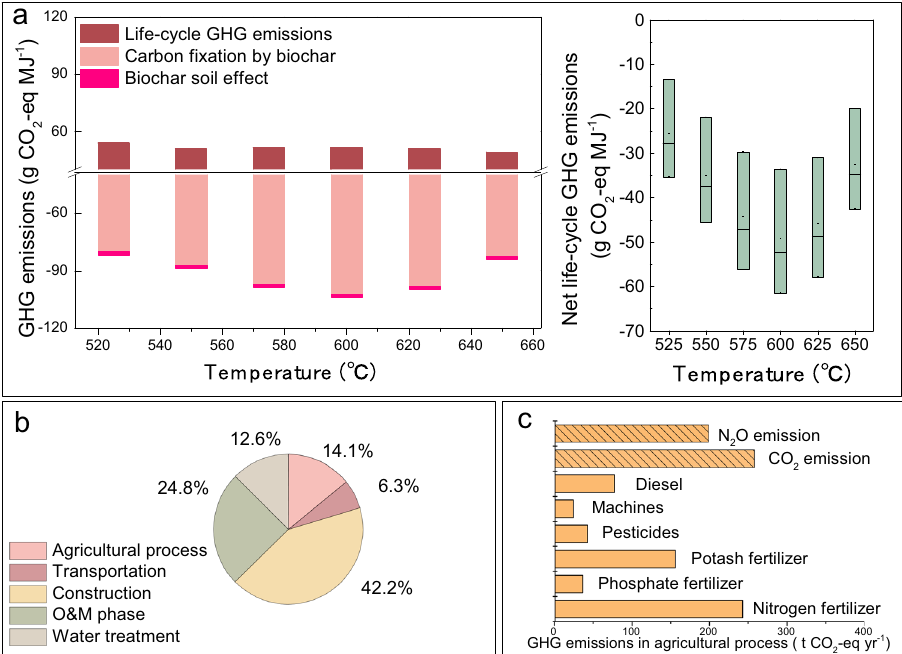
Fig. 3 The GHG emissions for a demonstration BIPP system with biochar sequestration (excluding fossil fuel offset). a Left fi gure presents life-cycle GHG emissions, carbon fi xation by sequestering biochar into soil (in fl uenced by the stability of biochar), and reduced emissions by biochar soil effect (explained in “ Methods ” ), while the right fi gure represents the net life-cycle GHG emissions for the whole system; b the GHG emission shares of fi ve subsystems at 600 °C with the lowest net life-cycle GHG emissions; c the GHG emissions for different components of agricultural production (with N 2 O and CO 2 emissions coming from soil as explained in Supplementary Note